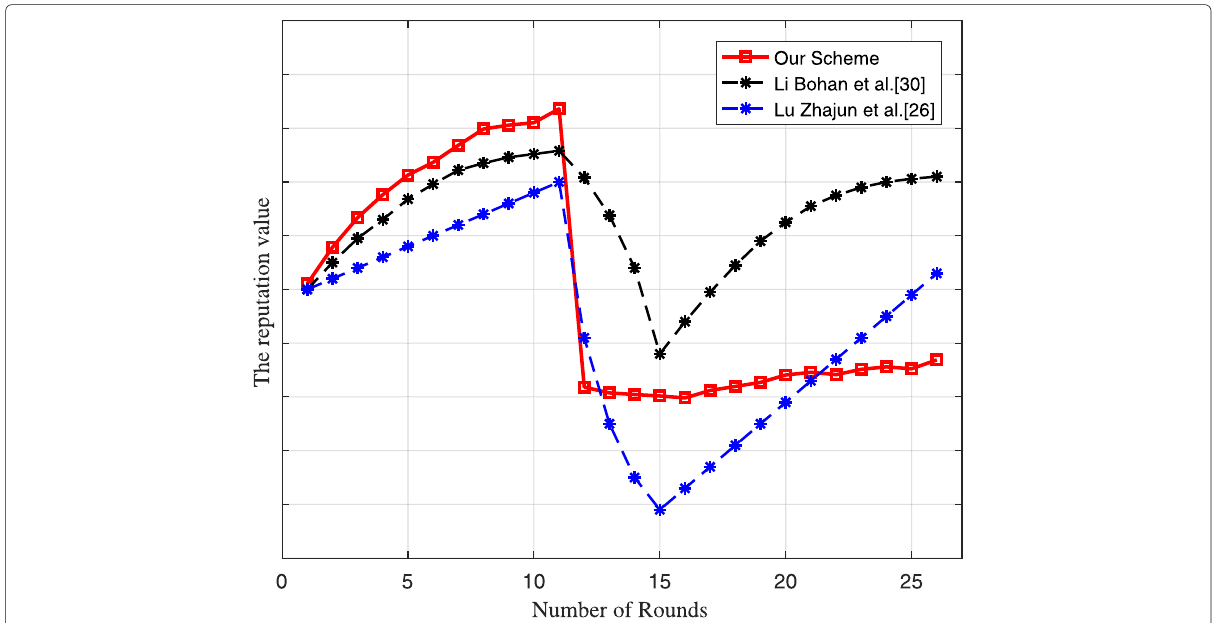
Fig. 5 The reputation value tendecy of malicious nodes compare with [26] and